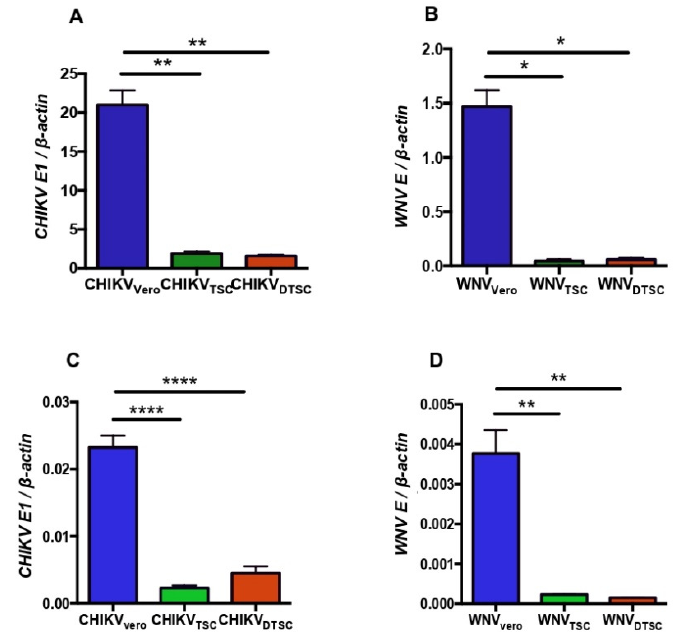
Figure 2. CHIKV and WNV generated in TSCs, and DTSCs decrease infectivity in vitro. Vero cells were infected with 1 MOI of CHIKV ( A ) or WNV ( B ) that was generated in Vero, TSCs, or DTSCs. At 24 h p.i., the ratio of CHIKV-E1 or WNV E to cellular β -actin was determined by qPCR. Vero cells were inoculated with 1 MOI of CHIKV ( C ) and WNV ( D ) grown in the different cells and incubated at 4 °C for 1 h. After washes, the attached viruses were quantified with qPCR. The results were analyzed by using a two ‐ tailed Student’s t ‐ test and are representative of at least two independent experiments and expressed as mean ± SEM. *, **, and **** denote p < 0.05, p < 0.01, and p < 0.0001, respectively.